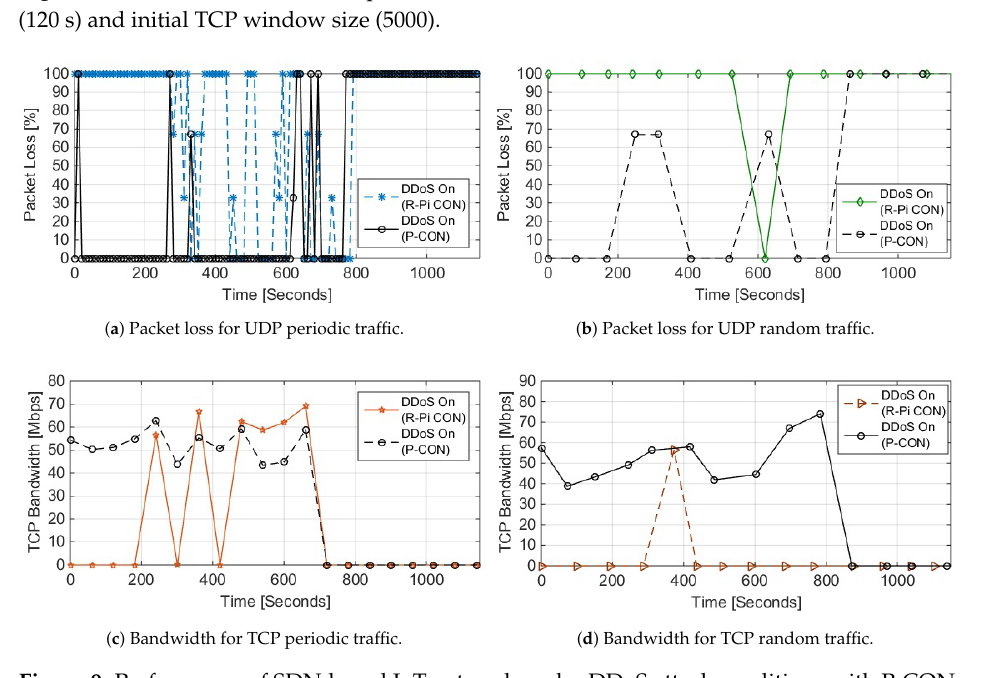
Figure 9. Performance of SDN-based IoT network under DDoS attack conditions with P-CON and RPi Controller (R-PI